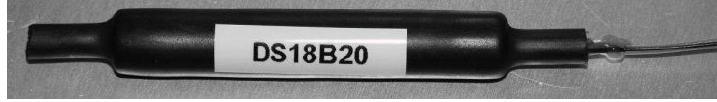
Figure 16. Digital temperature sensor with a waterproof container.